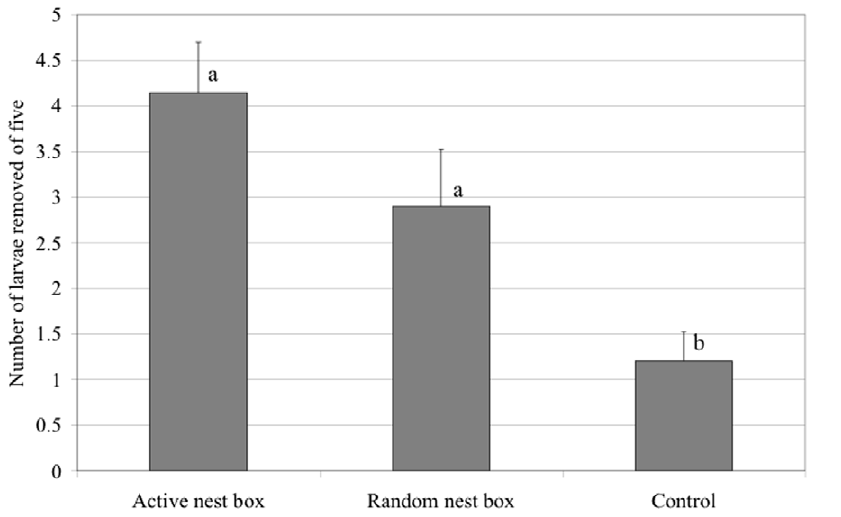
Figure 2. Mean number ( ± SE) of five lepidopteran larvae removed per transect in the pooled control (n=10), nest box treatment (n=10), and below active Western Bluebird nests (n=7). Different letters indicate significant differences ( P , 0.05).